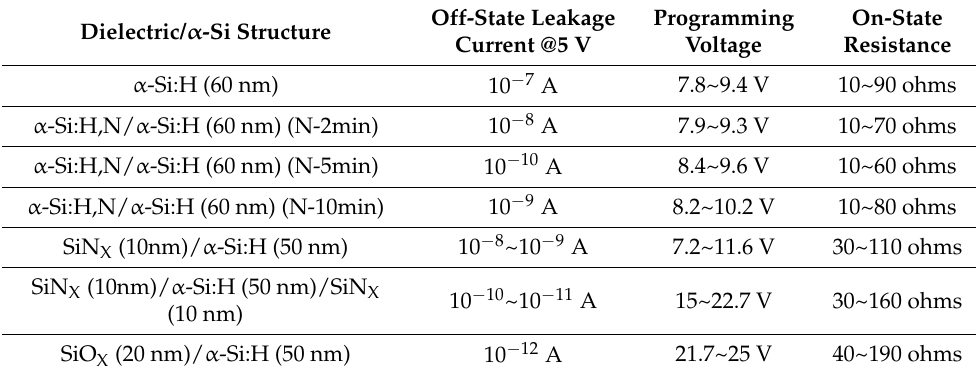
Table 1. The characteristics of different dielectric/ α -Si structures. Dielectric/ α -Si Structure